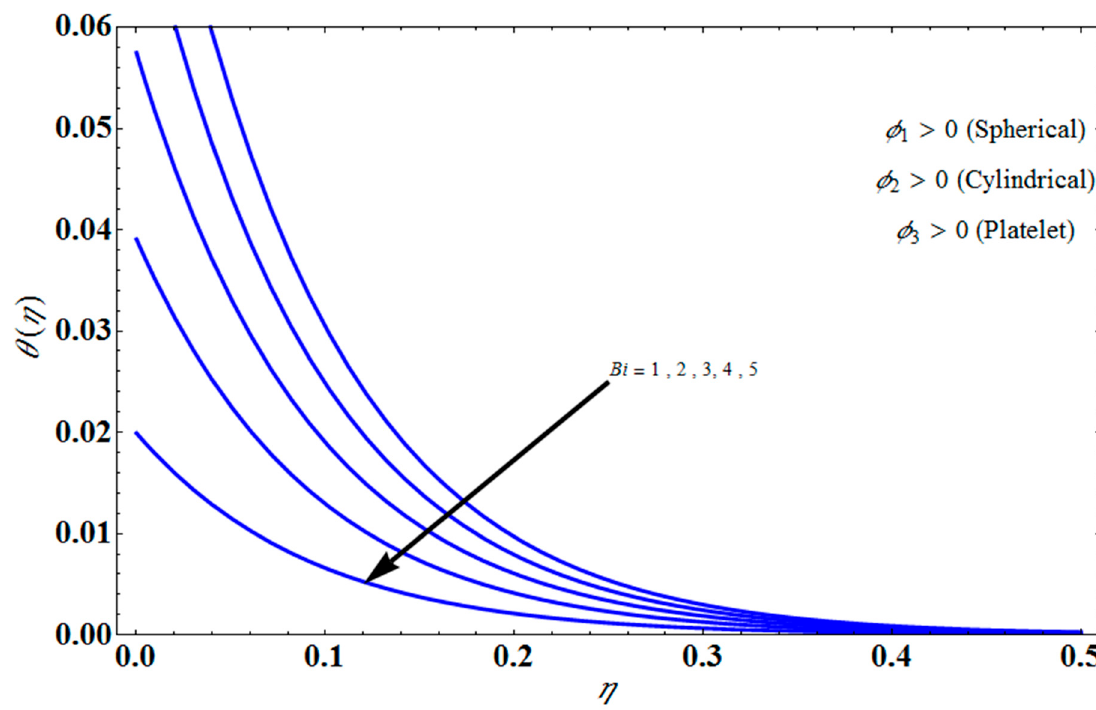
( ) θ η ( ) θ η η η on for different values of Bi . on for different values of Bi .